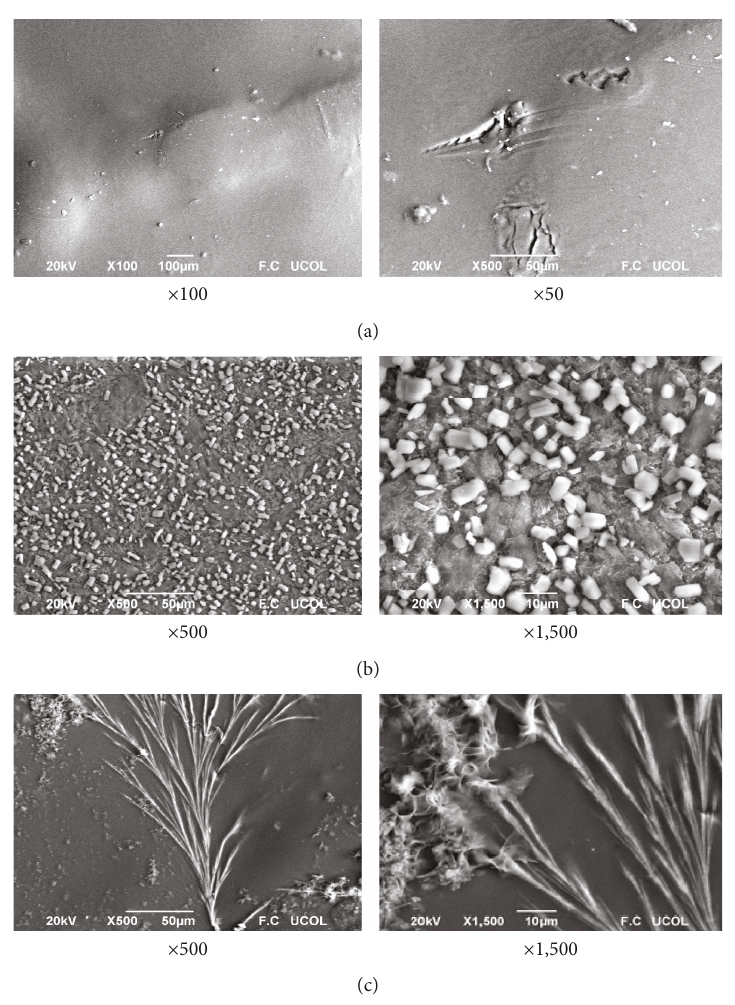
Figure 5: Micrographs with magni fi cations, the samples are (a) xerogel of HEC/PAAm without drug, (b) xerogel of HEC/PAAm with drug ASA incorporated by swelling, and (c) xerogel of HEC/PAAm with drug ASA incorporated in the synthesis.